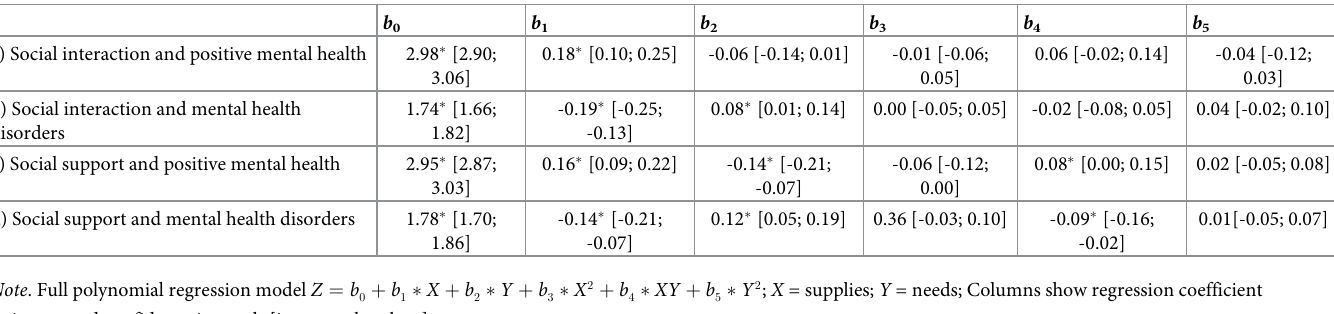
Table 3. Estimated polynomial regression